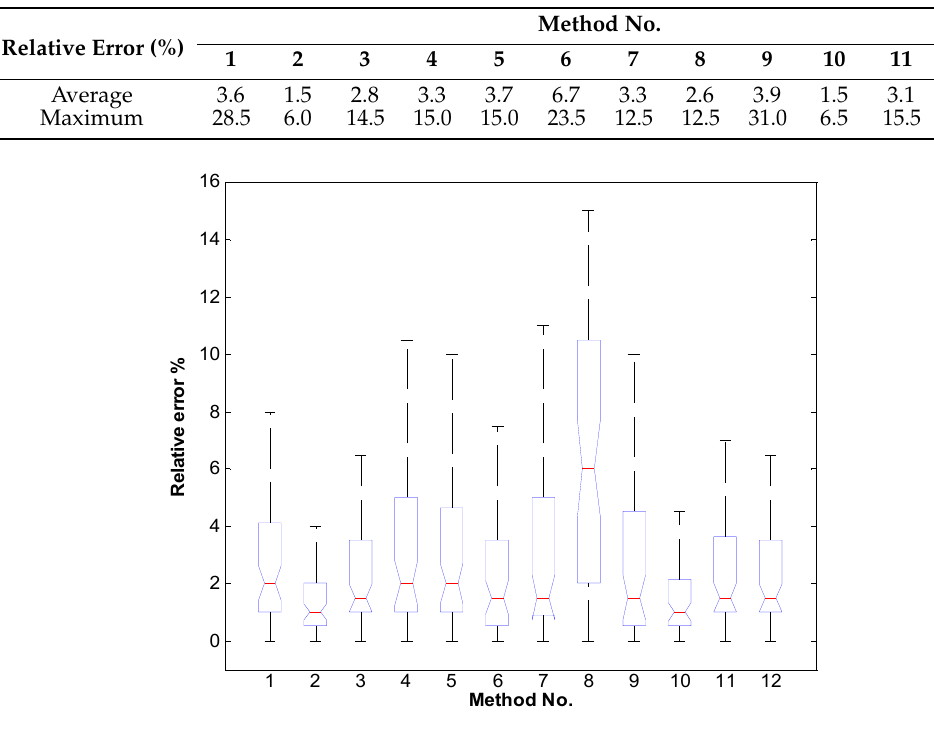
Figure 7. Box plot of the methods’ (Table 1) relative errors.